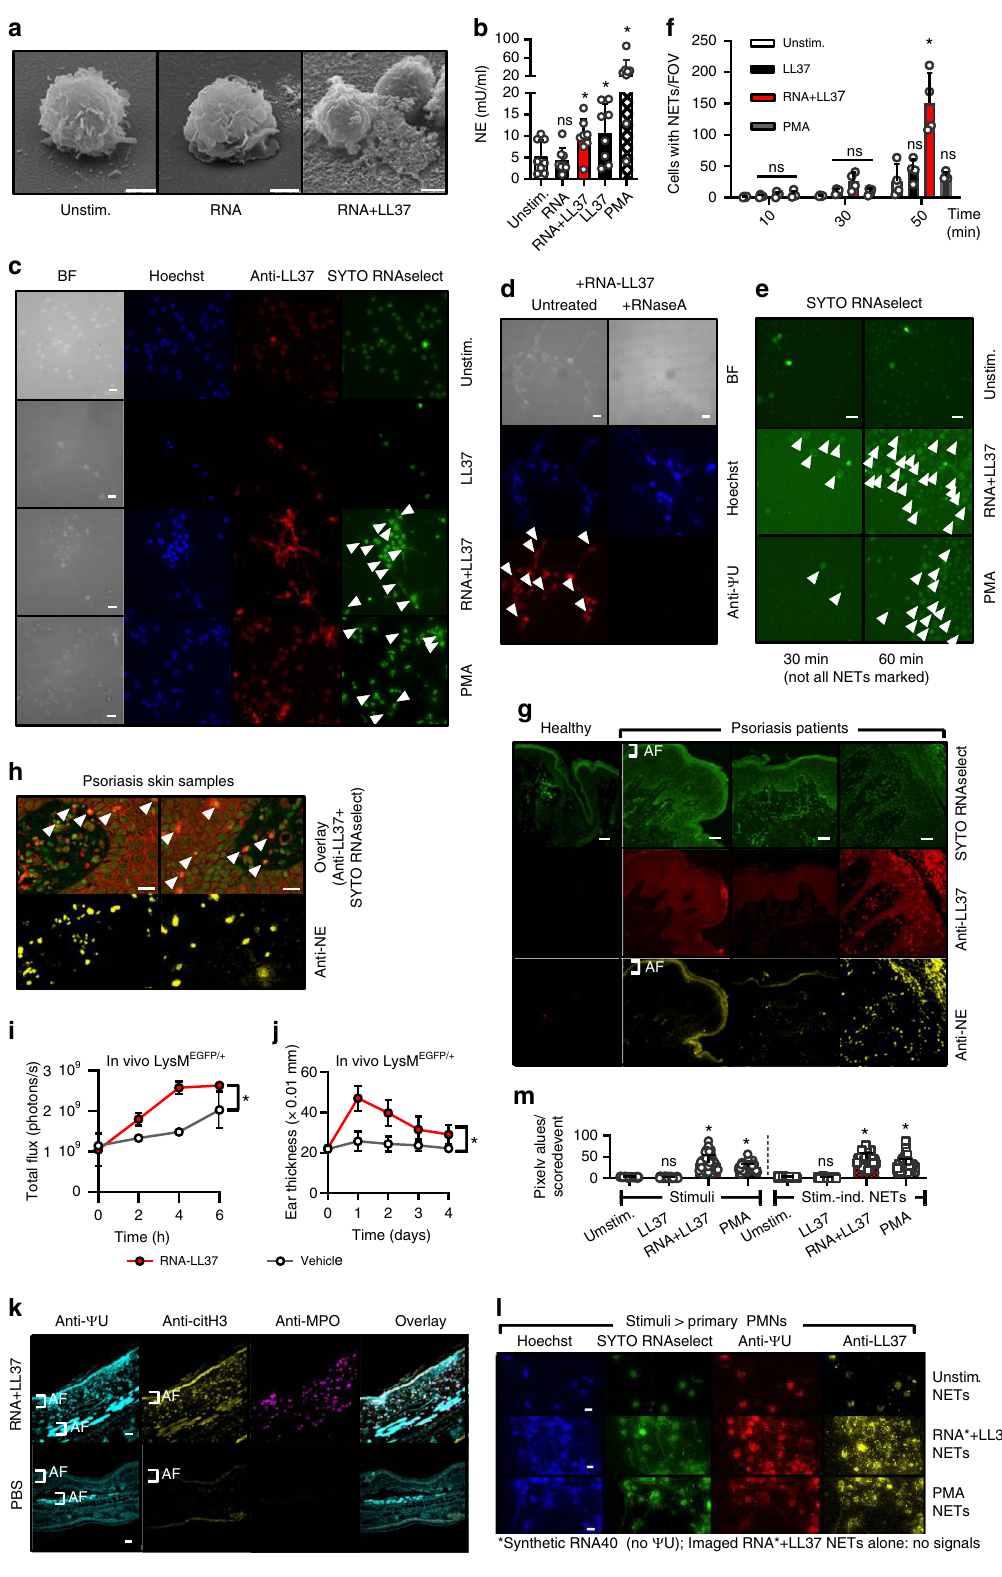
RNA-LL37 complexes and NETs activate PMNs via TLR8/ propagating feed forward loop of immune activation that might TLR13 . In order to gain an insight which receptor mediates the apply to skin PMNs. At the same time, we provide evidence for the so far unappreciated existence and physiological relevance of observed effects of RNA-LL37 in primary PMNs, we fi rst com- RNA in NETs, which we would like to term NET-associated RNA pared BM-PMNs from WT mice and mice de fi cient for Unc93b1 , or naRNA (see Discussion). a critical chaperone of endosomal TLRs 29 . Evidently, not only the NATURE COMMUNICATIONS| (2020) 11:105